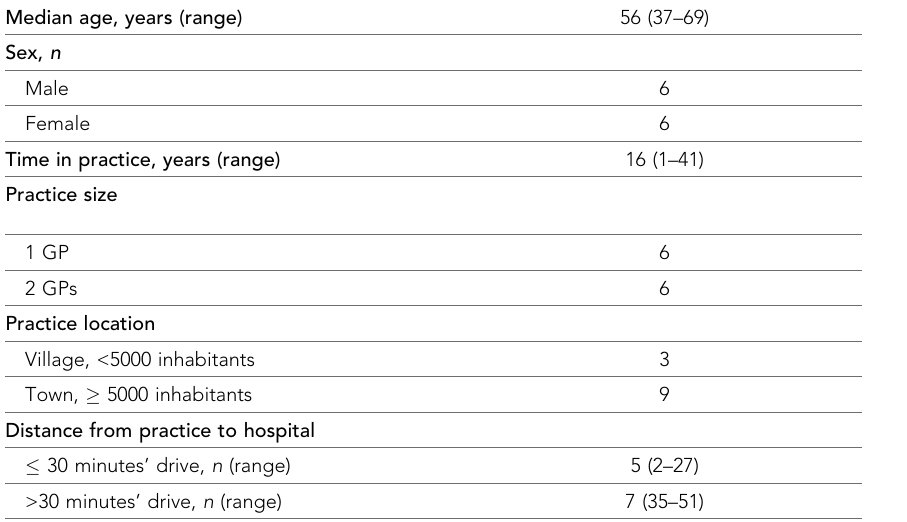
Table 2. Personal and demographic details of the GPs who participated in the study, n = 12 Median age, years